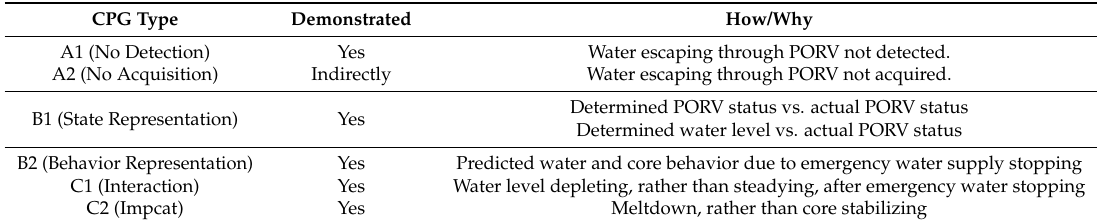
Table 5. TMI2 model coverage of CPG